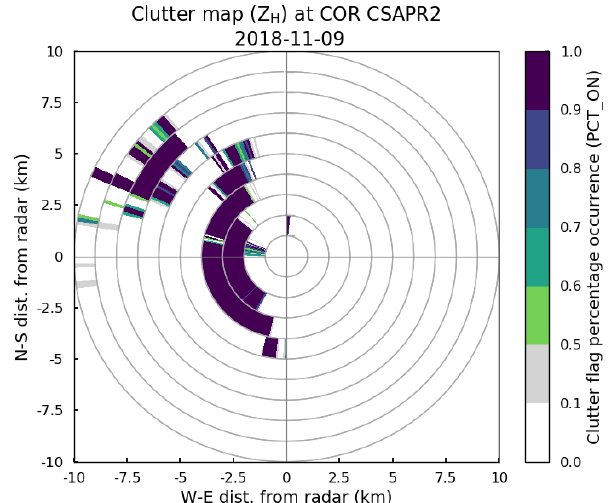
Figure 5. The clutter map calculated from the CACTI CSAPR2 PPI scans on 9 November 2018. The map predominantly uses the clutter caused by the hills to the west of the radar. The clutter to the east of the radar is out of range of the 10km limit for